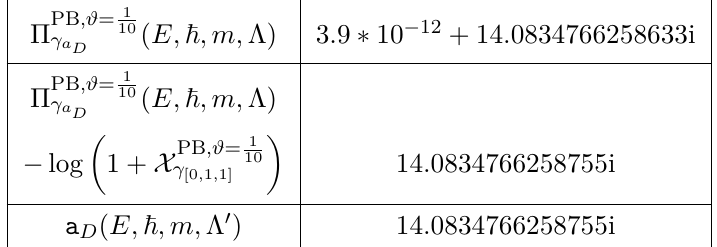
Table 4 . Transformation to compare Padé-Borel summation Π PB for E, ~ , m, Λ are those in